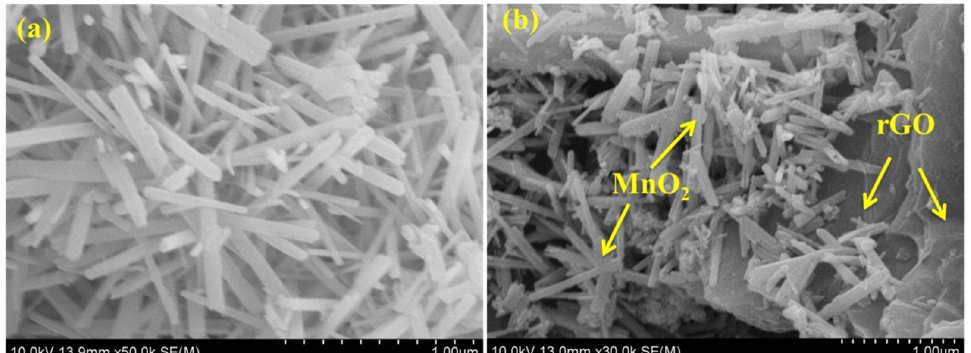
Figure 2. SEM images of MnO 2 ( a ) and MnO 2 /rGO ( b ).